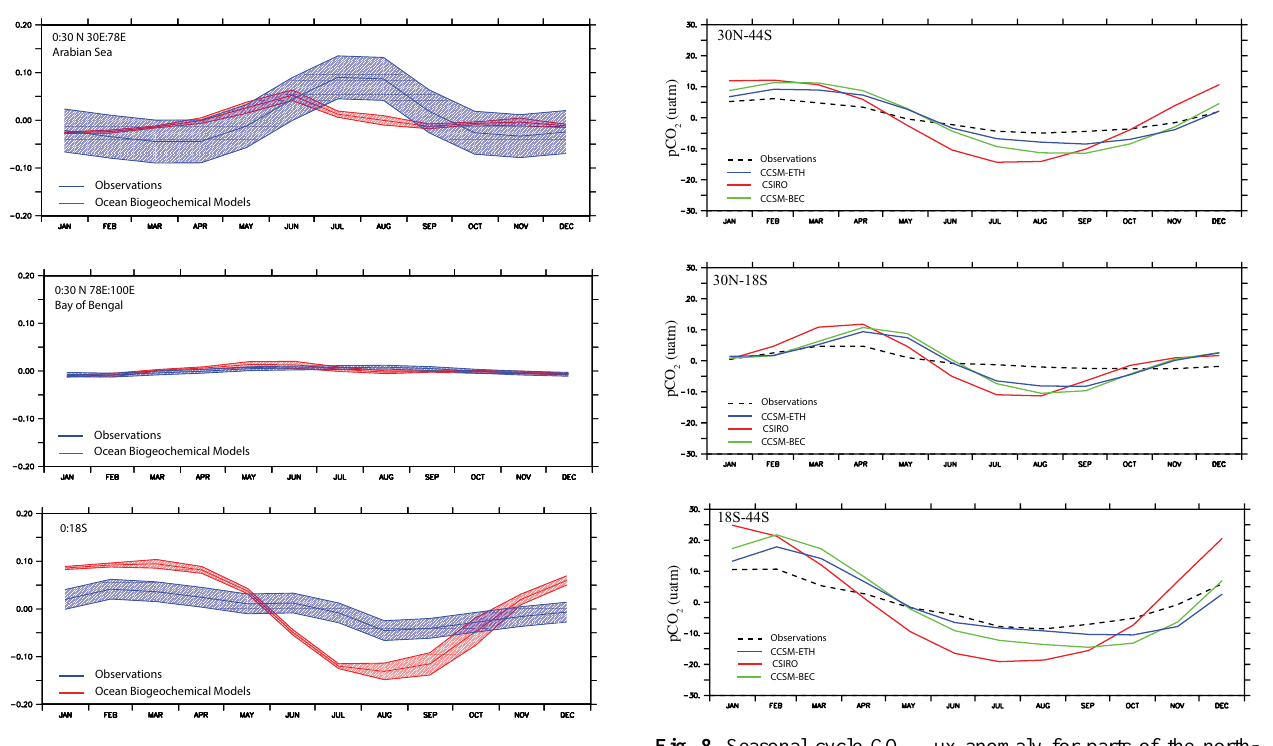
Fig. 7. Seasonal cycle p CO 2 anomaly of the Indian Ocean CO 2 flux (µatm) from observations and ocean biogeochemical models for total Indian Ocean (30 ◦ N–44 ◦ S; upper), the northern Indian Ocean (30 ◦ N–18 ◦ S middle) and the southern Indian Ocean (18– 44 ◦ S; lower).